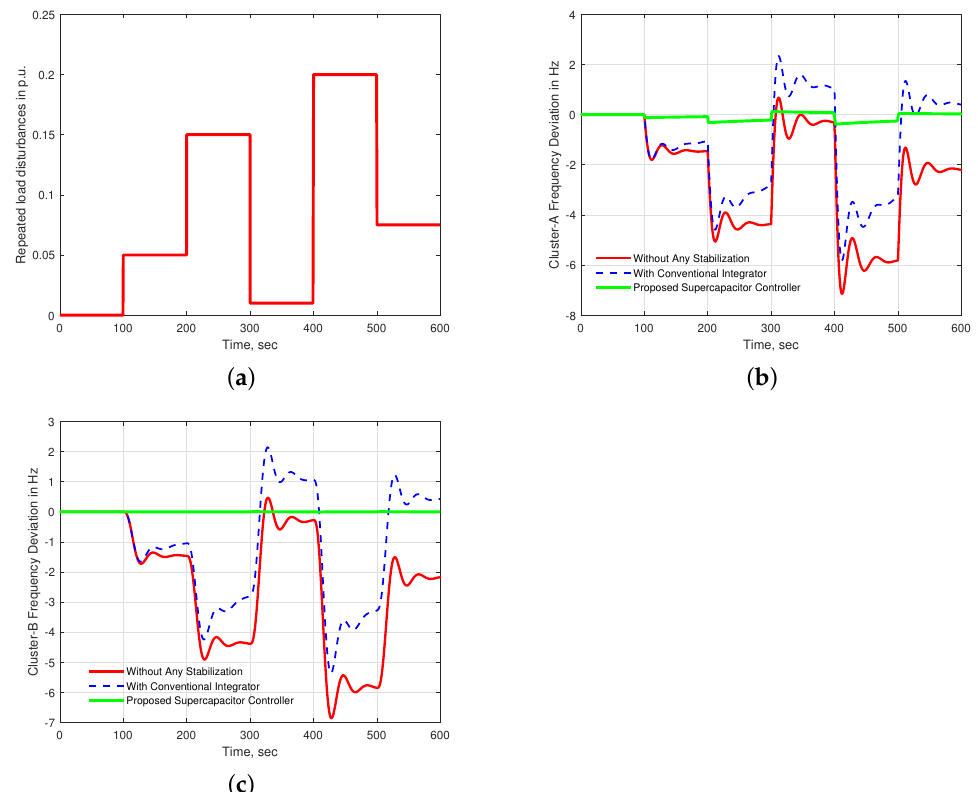
Figure 17. ( a ) Repeated load change in cluster B; ( b ) frequency variation in cluster A; ( c ) frequency variation in cluster